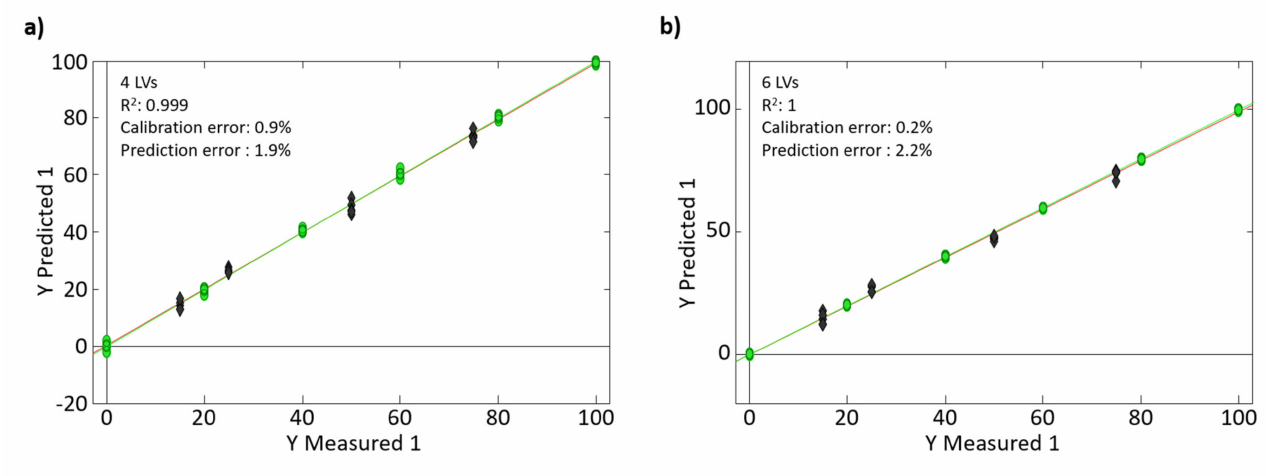
Figure 5. PLS regression scatter plots of measured vs. predicted percentages of adulterant for the adulteration case of Vietnamese Arabica coffee with a wheat flour when ( a ) HPLC-UV and ( b ) HPLC-FLD fingerprints were used as sample chemical